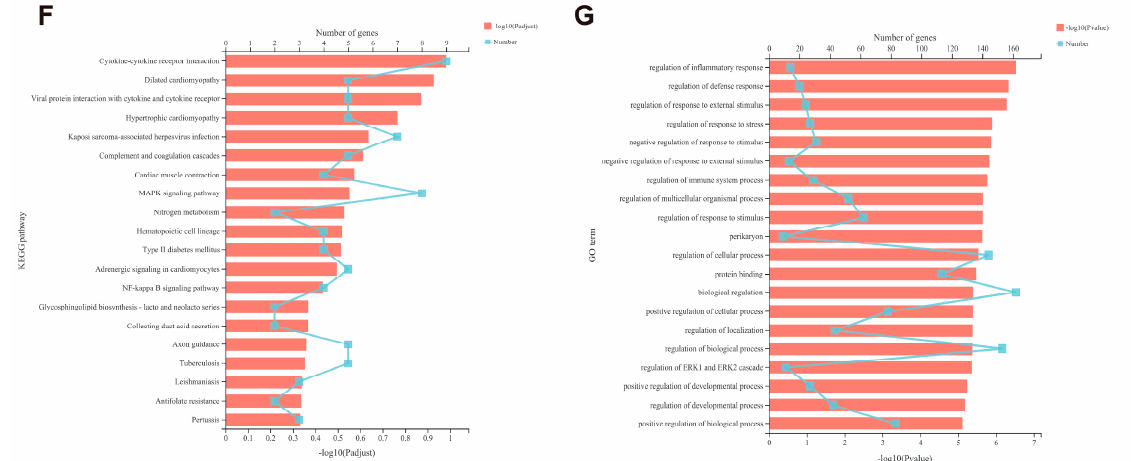
Figure 5. M. smegmatis infected RAW264.7 cells treated with BAY 11-7082 for 24 h. Transcriptome high-throughput sequencing analysis was performed. ( A ) Volcano diagram: based on the quantitative results of expression, the DEGs between the two groups were obtained. The blue was the lowly expressed genes in the treatment group, and the red was the highly expressed genes in the treatment group. ( B ) The PPI network: according to the comprehensive score greater than 0.4, the top 100 differ- entially expressed genes were screened, and discrete gene nodes were deleted to obtain PPI network. ( C ) Heat map: each column represents a sample (B1, B2, and B3 are BAY 11-7082 treated groups, and A1, A2, and A3 are control groups), each row represents a gene, and the color in the figure indicates the expression level of the gene/transcript in the sample; red represents the higher expression level of the gene/transcript in the sample, and the blue represents the lower expression level. The left side shows the gene/transcript clustering dendrogram, where the closer the two gene/transcript clades are, the closer their expression levels are. ( D , E ) Subcluster trend graph: he abscissa is the samples name (B1, B2, and B3 are the BAY 11-7082 treatment group, and A1, A2, and A3 are the control group), and the ordinate is the gene expression level in the samples, each line in the graph represents a gene change trend, and the blue line represents the change trend of the average expression of all gene transcripts. ( F ) Based on KEGG database, gene function enrichment analysis was performed; the lower abscissa represents log10 ( p value), and the upper abscissa represents the number of enriched genes. ( G ) Based on GO database, gene function enrichment analysis was performed; the lower abscissa represents log10 ( p value), and the upper abscissa represents the number of enriched